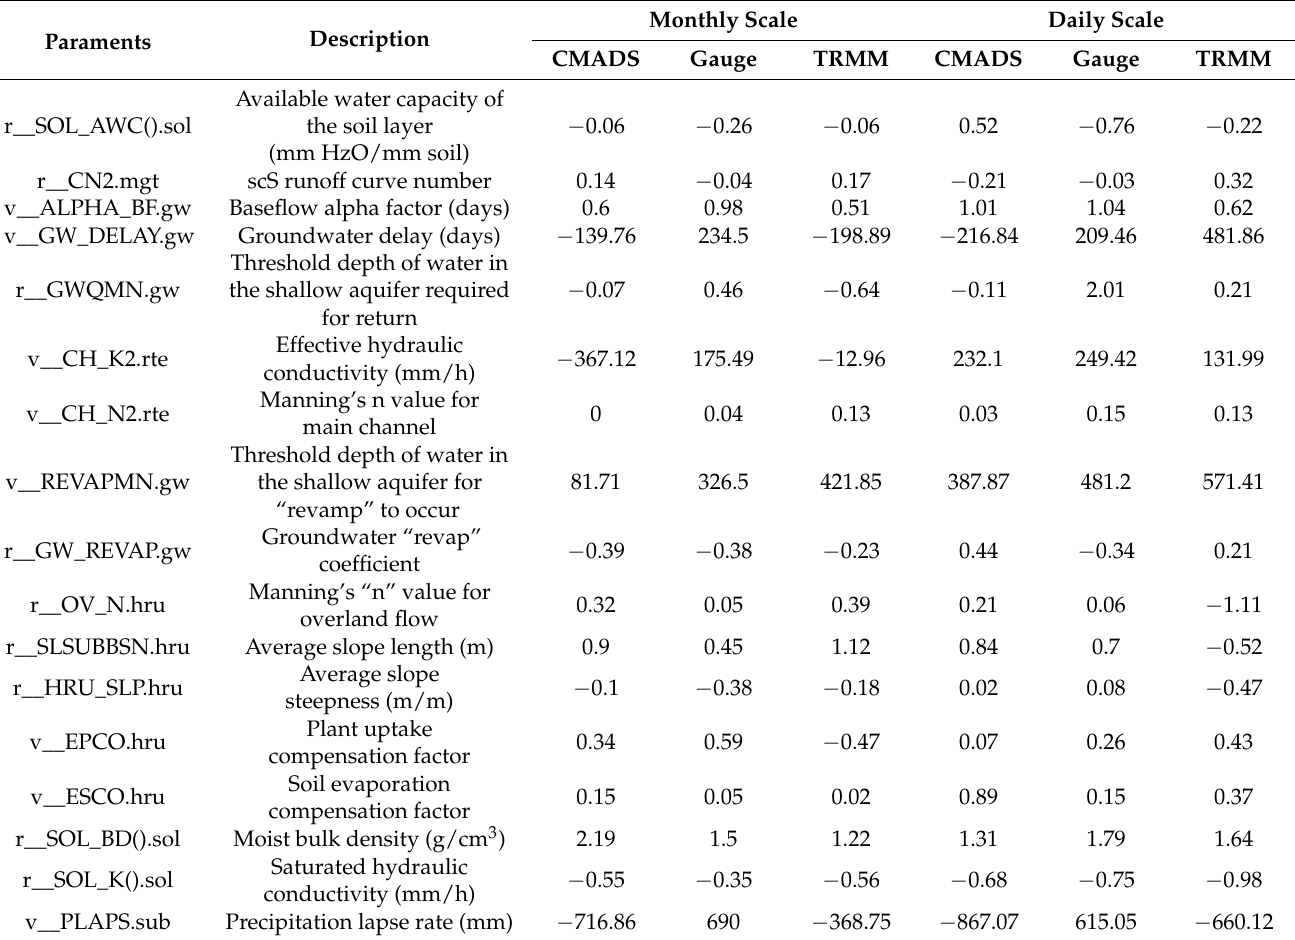
Table 6. Hydrological parameters chosen to calibrate the model (r_ and v_ mean a relative change and a replacement to the initial parameter values,